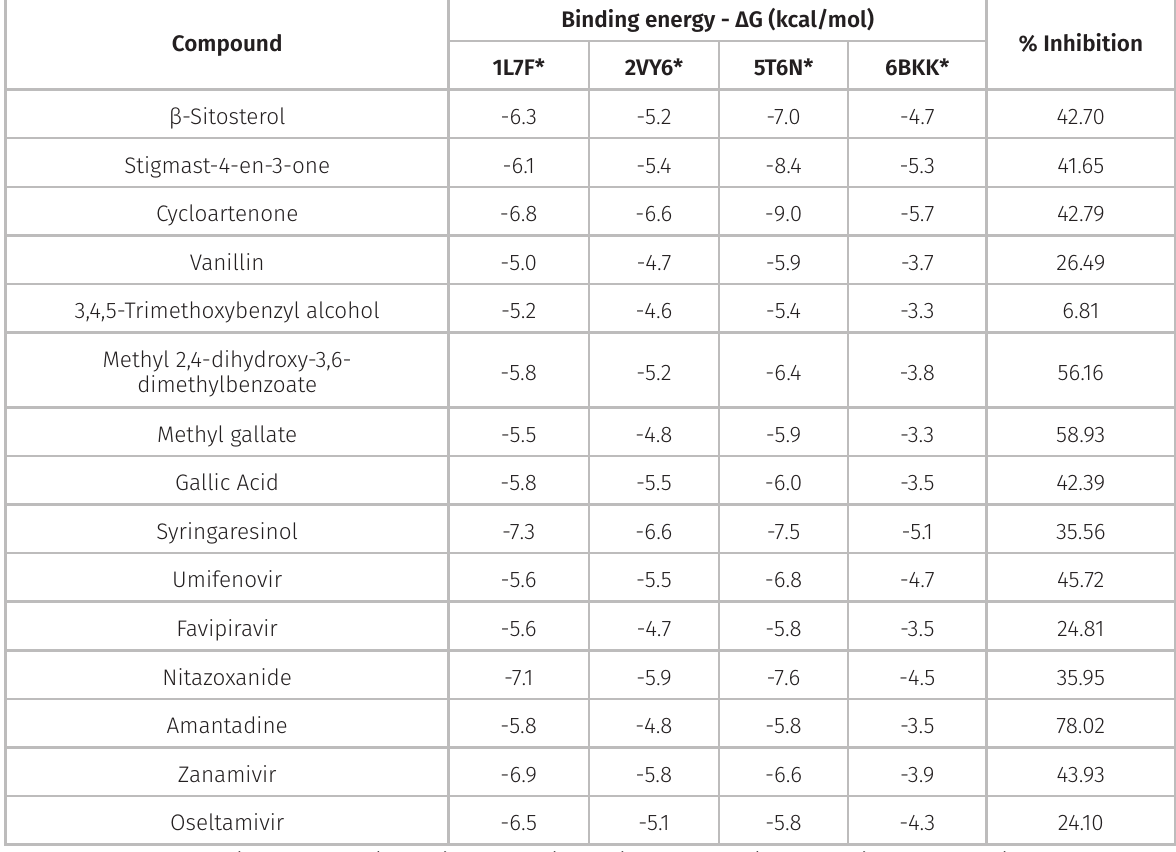
Table II. Binding energy (ΔG - kcal/mol) and predicted percentage inhibition of the S. brasiliensis phytocompounds and drug models (positive